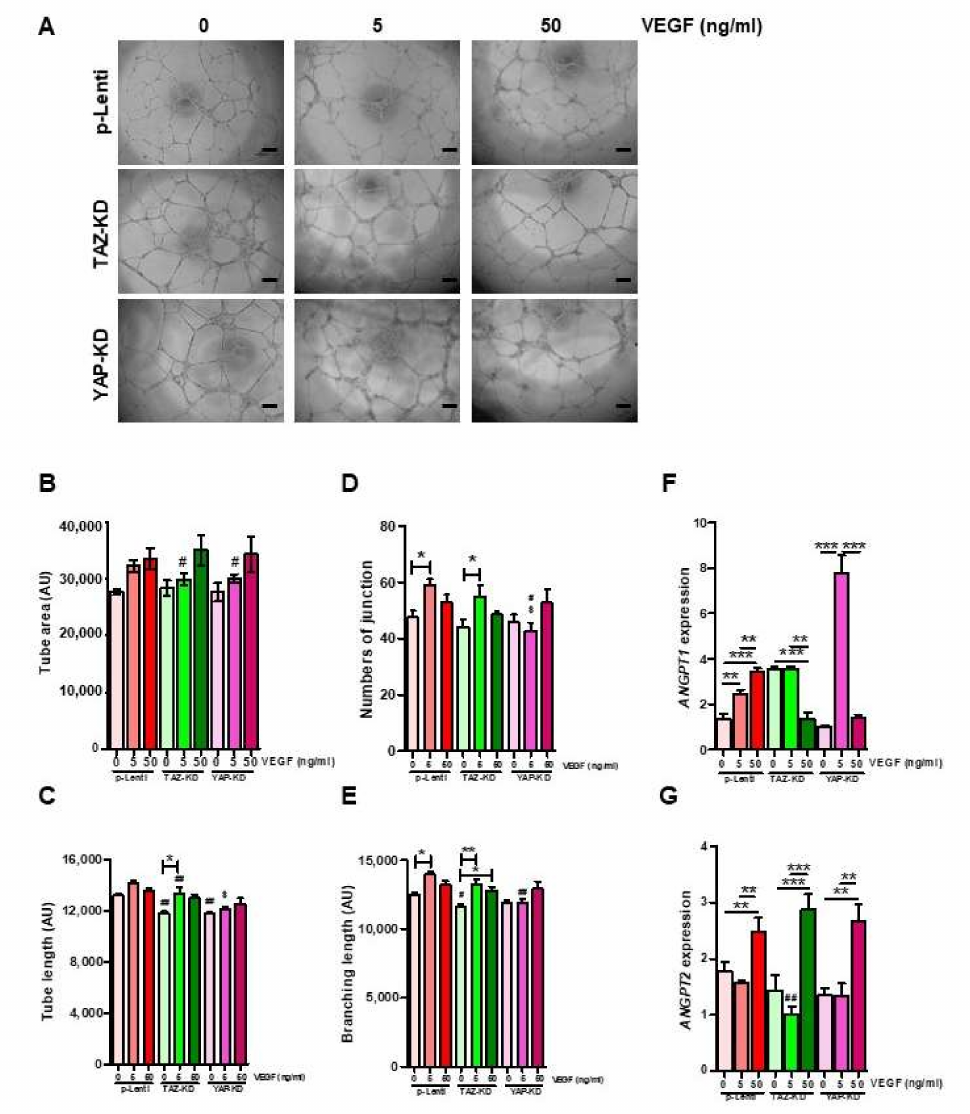
Figure 6. VEGF rescued tube-forming ability of KD-EPCs. 10,000 EPCs were seeded on Matrigel- coated wells of 96-well plate in quadruplicates and let to form the tube-like structure for 12 h in the absence or presence of VEGF at the indicated concentrations. Several angiogenic parameters were quantified by ImageJ software ( A – E ). The expression levels of ANGPT1 and ANGPT2 in the VEGF-treated EPCs were determined by qRT-PCR ( F , G ). * p -value < 0.05; ** p -value < 0.01; and *** p -value < 0.001; # p -value < 0.05, and ## p -value < 0.01 (TAZ-KD and YAP-KD vs. pLenti at the same dose of VEGF); $ p -value < 0.05 (YAP-KD vs. TAZ-KD at the same dose of